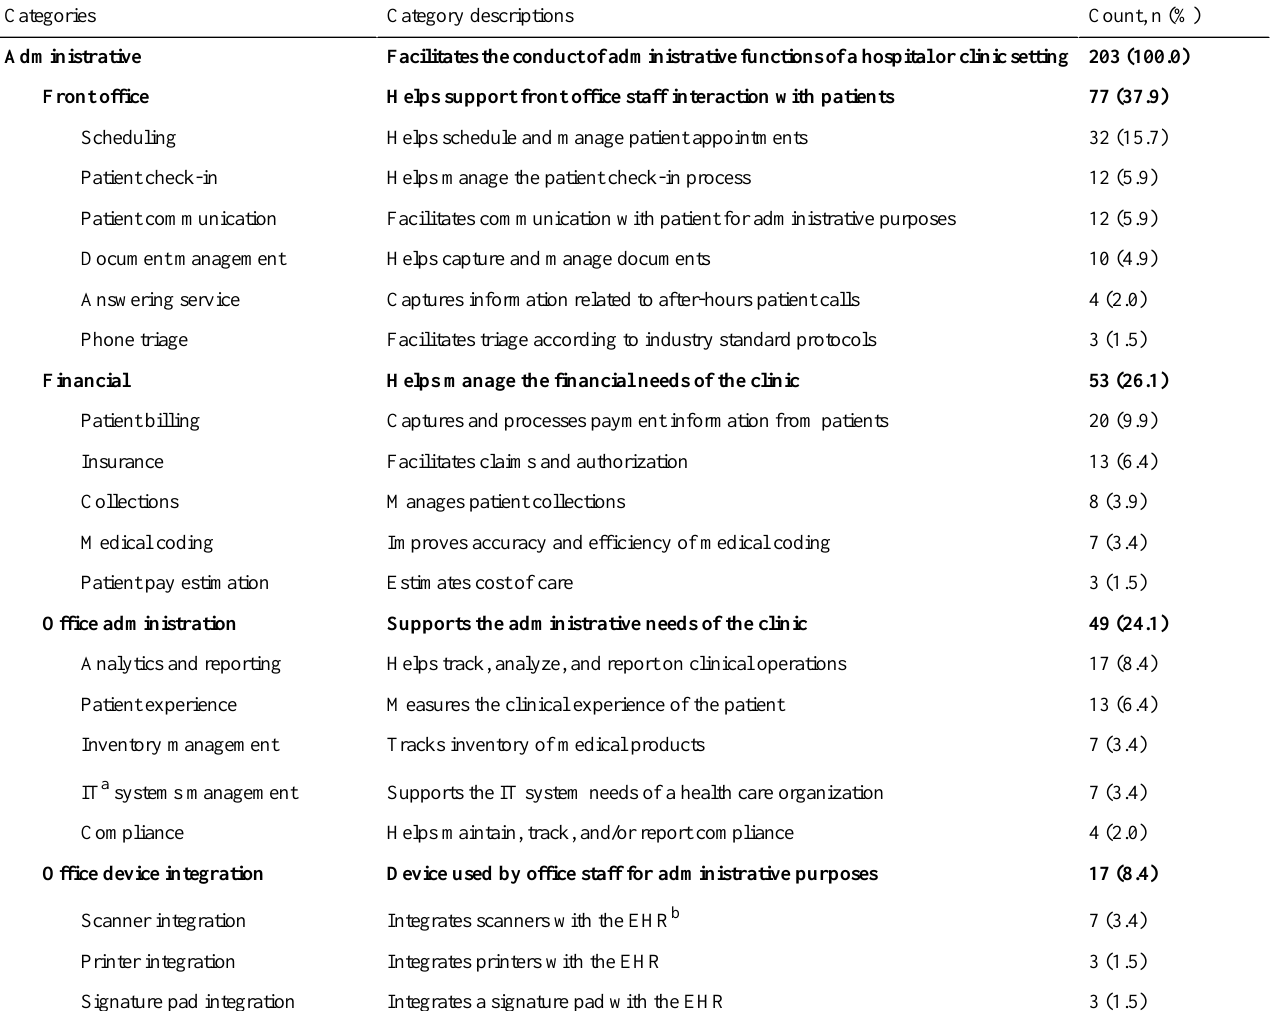
Table 2. Category definitions and counts for administrative apps (n=203).